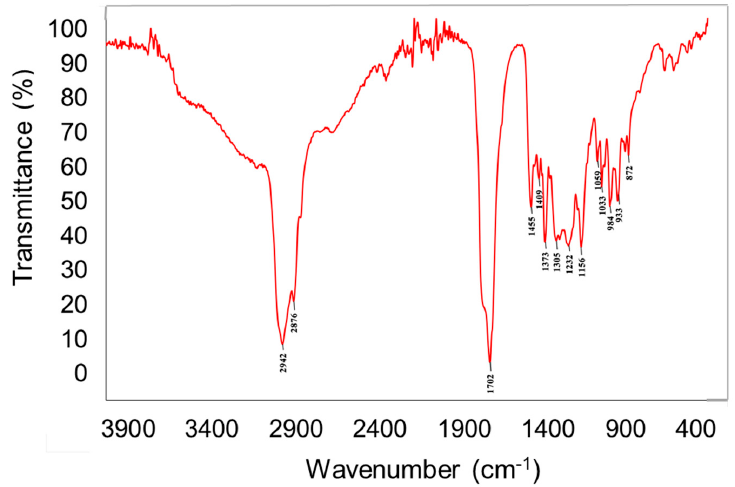
Figure 1. FTIR spectra of Heterobasidion annosum extract.